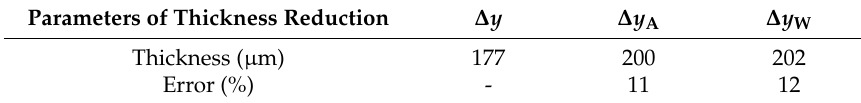
Table 2. Determination of thickness reduction from measured strain, thickness, and